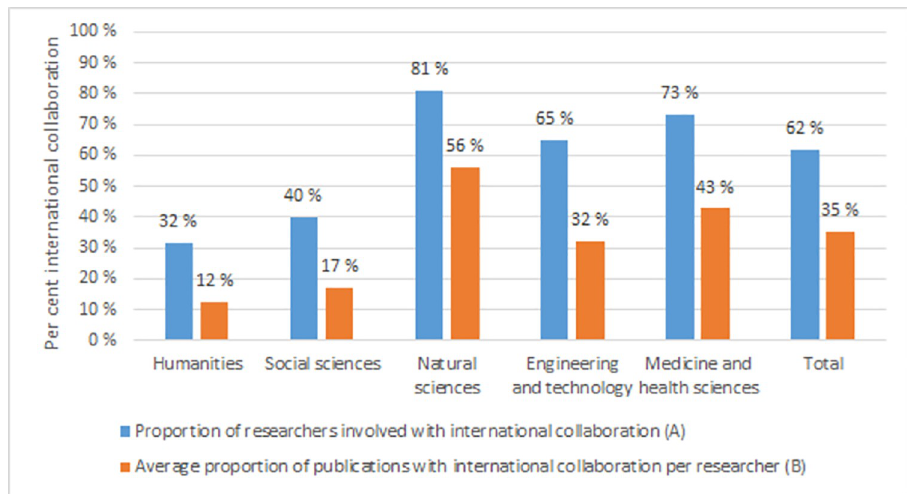
Fig 1. Proportion of researchers involved in international collaboration (A) and average proportion of publications with international collaboration per researcher (B) by major fields.